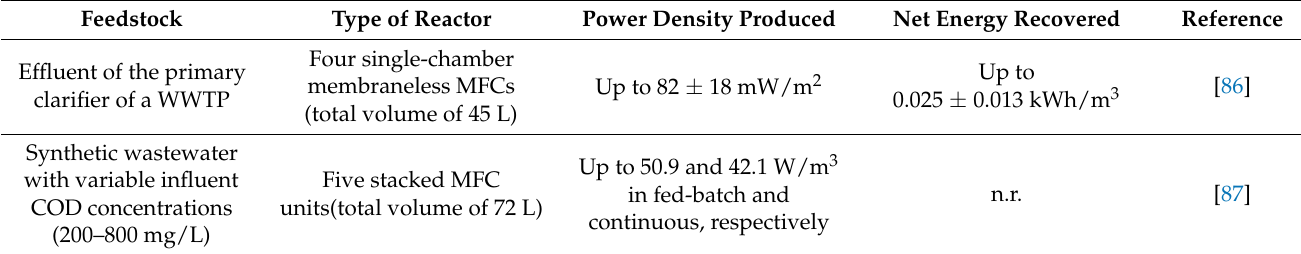
Table 8. Configuration and performances of microbial fuel cells operation at pilot-scale.